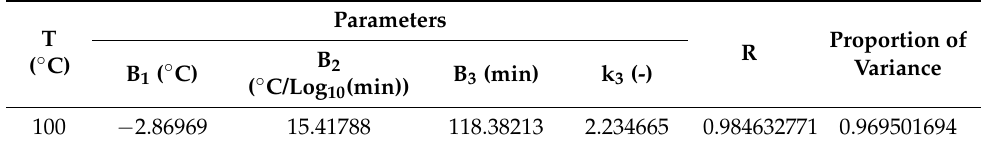
Table 2. Equation (66) parameters obtained after adjustment to experimental moisture content data [15].